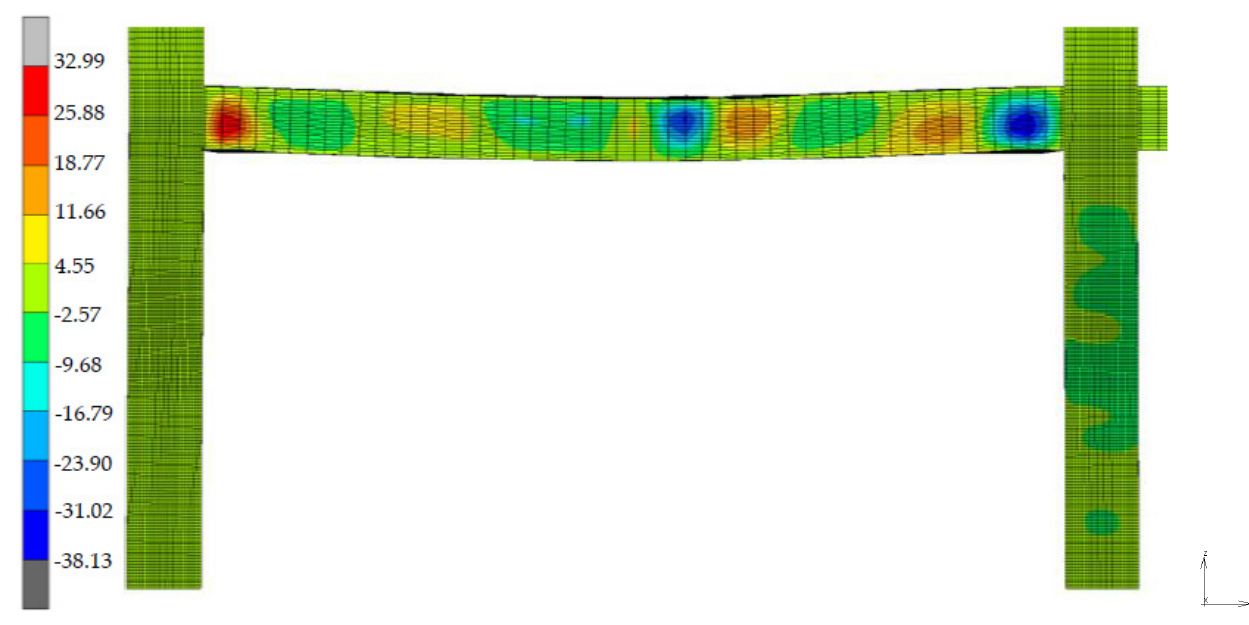
Figure 21. Deformed shape of the left frame of the first story (scenario A) and the x ‐ displacement field (in mm).